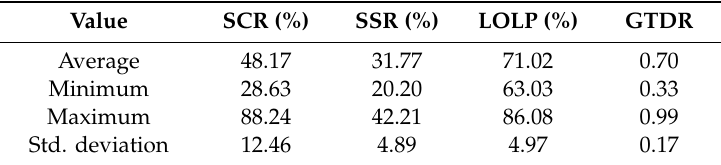
Table 2. Annual values for the load matching indicators (n =